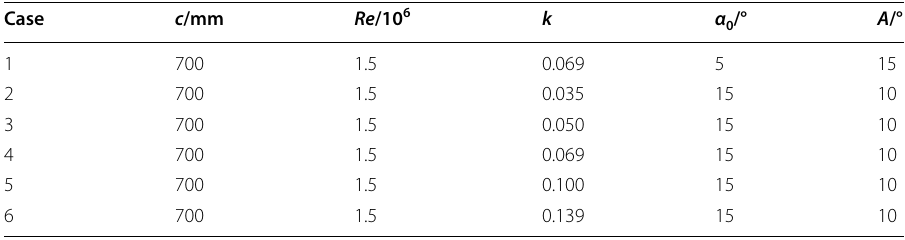
Table 1 Experimental state